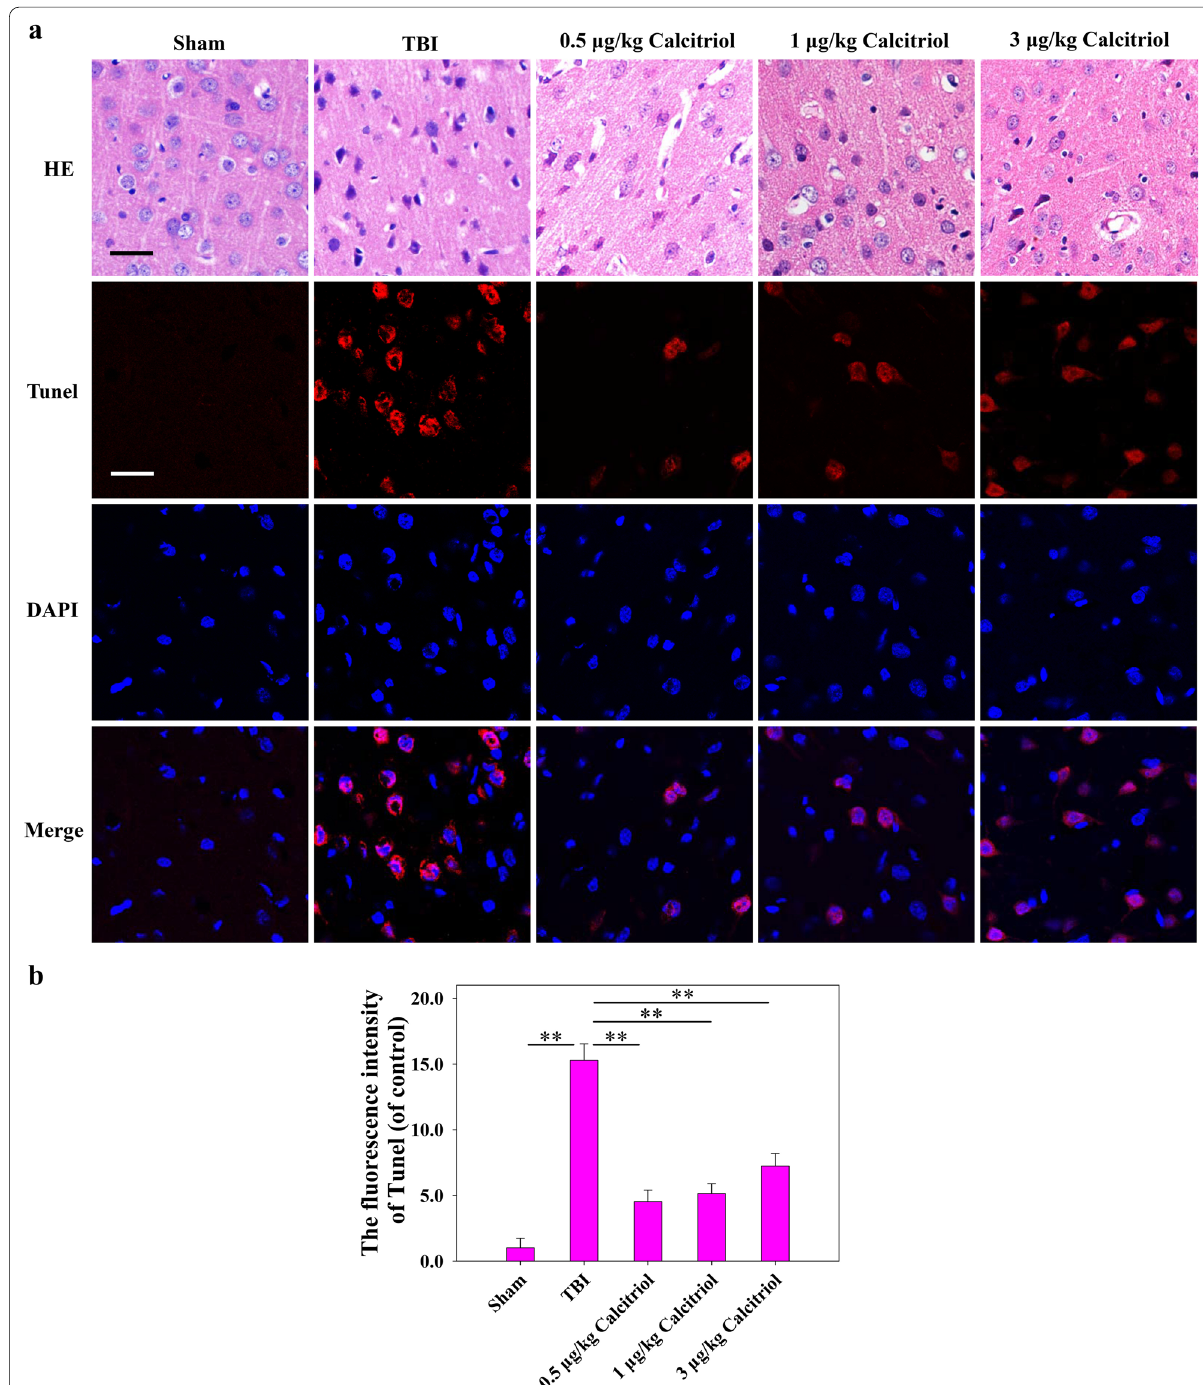
Fig. 2 Calcitriol treatment mitigated TBI-induced histopathological changes. a Representative images of the histological assessment of the frontal cortex via hematoxylin and eosin (H&E) and TUNEL staining (Bar means SEM ( n 5). ** P < 0.01 versus the indicated groups. (Sham: sham-operated group; TBI: TBI model group; Calcitriol: TBI ± =